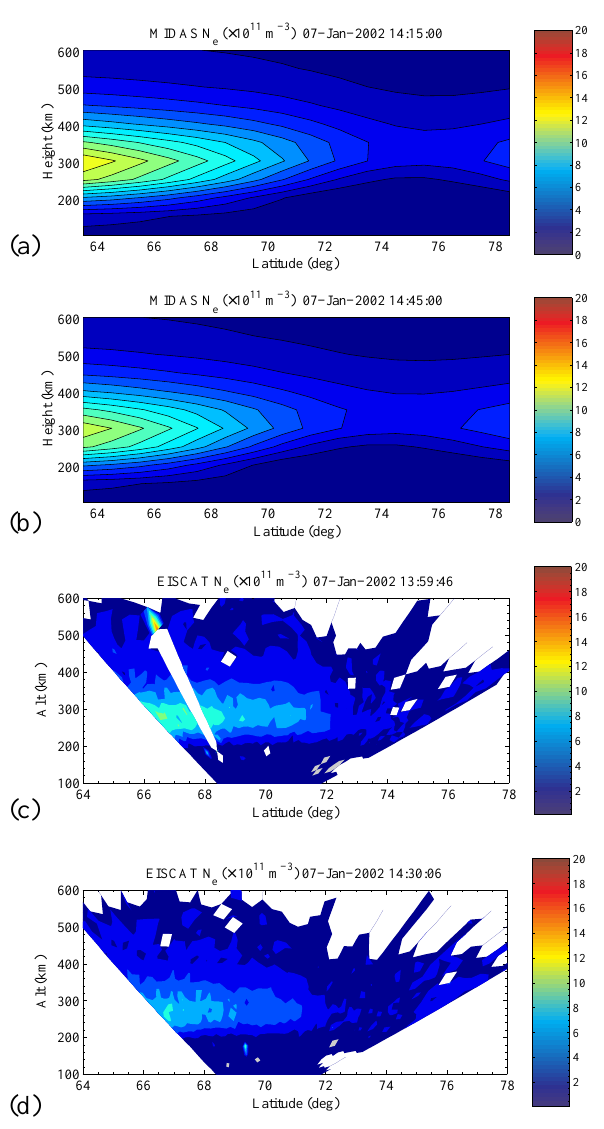
Fig. 3. Electron concentration at the longitude of the EISCAT radar between 14:00 and 15:00 UT: ( a ) and ( b ) plotted from GPS data using MIDAS; ( c ) and ( d ) plotted from EISCAT data.